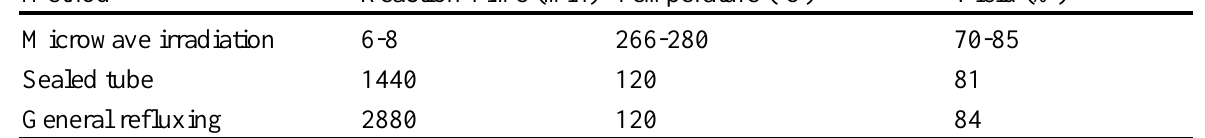
Table 1. Comparison between methods, times, temperatures and